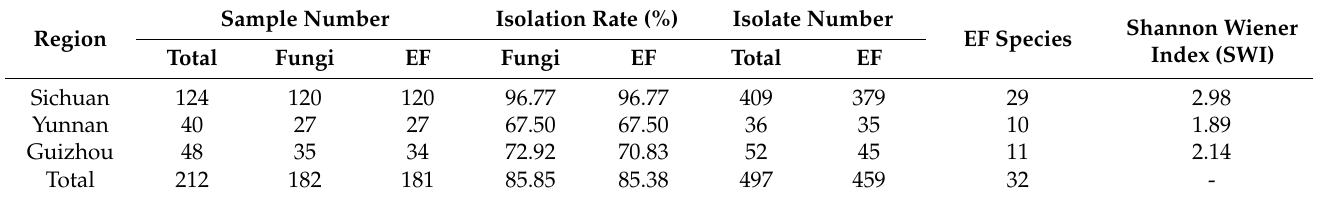
Table 2. The fungi isolation and biodiversity of different regions.